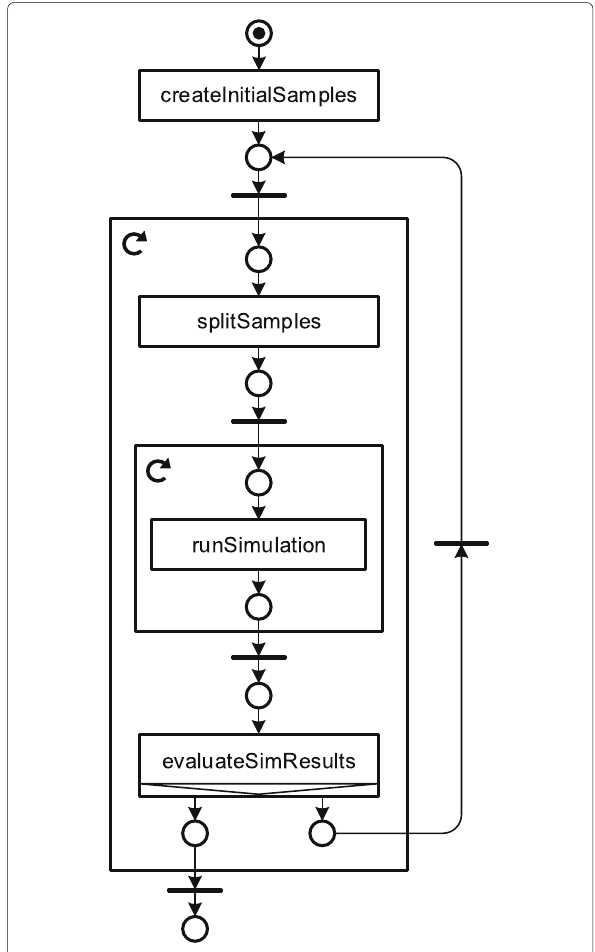
Fig. 19 The shape optimisation